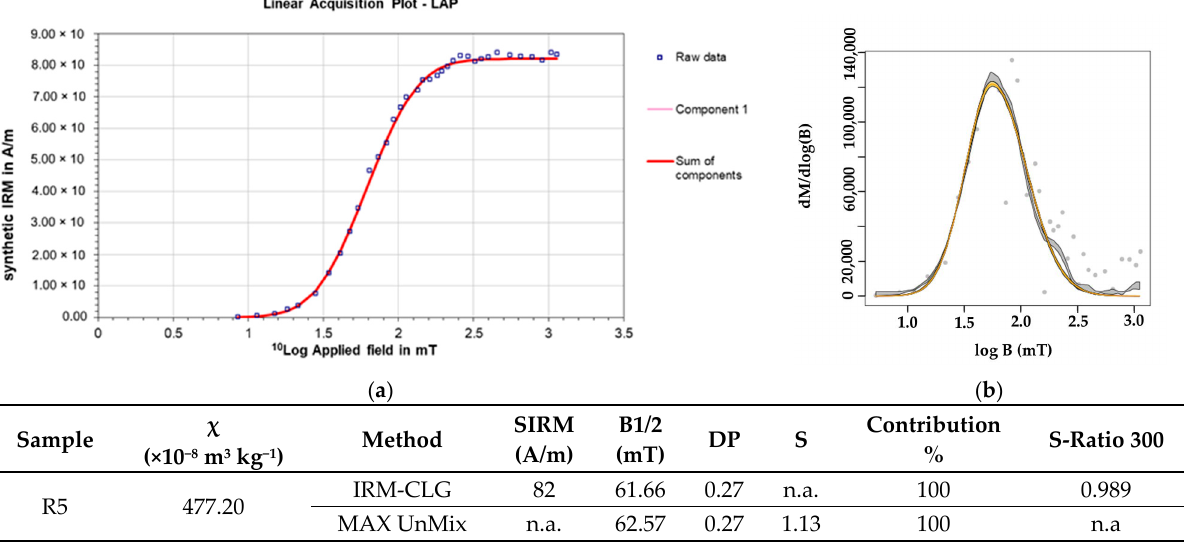
Figure 12. Adjustments of the IRM curve of a representative sample (R5) using: ( a ) Kruiver et al. [23] software, displaying a IRM curve adjustment versus the logarithm of the field applied to a linear scale (LAP); and ( b ) MAXUnMix software [24], where the solid yellow line represents the coercivity distribution of the sample, and the thickness of the line represents the standard deviation of the estimated error; ( c ) IRM parameters obtained from the IRM curve interpretation, both by IRM-CLG treatment and MAXUnMix software ( χ —magnetic susceptibility; SIRM—saturation of isothermal remanent magnetization; B1/2—coercivity/ fi eld at which half of the SIRM was reached; DP—dispersion parameter; S—skewness. S-ratio (IRM300 mT/IRM1000 mT); n.a.—not a tt ributed value).